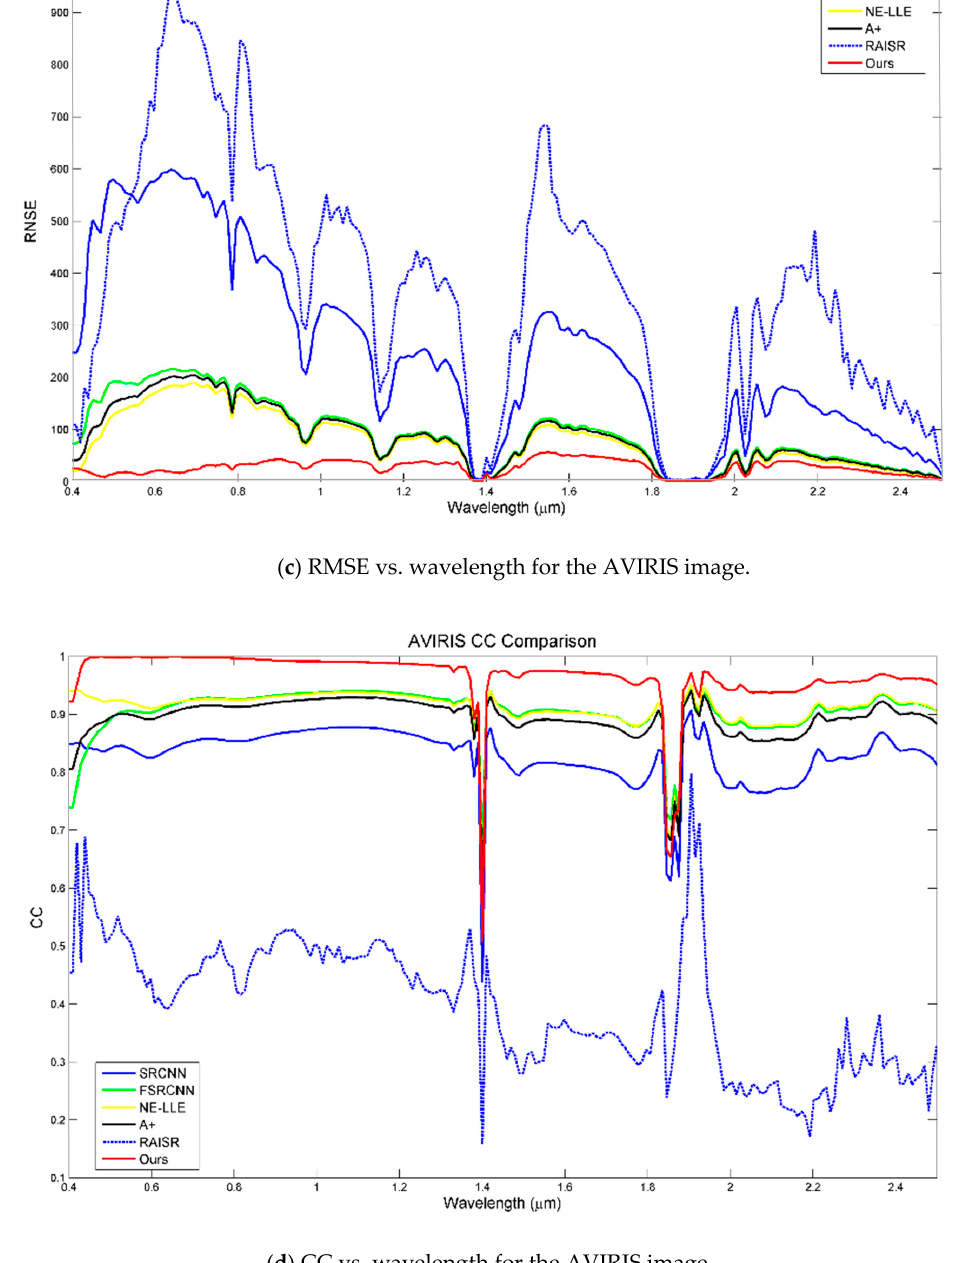
Figure 7. Comparison of RMSE and CC between our method and methods in Group 4.